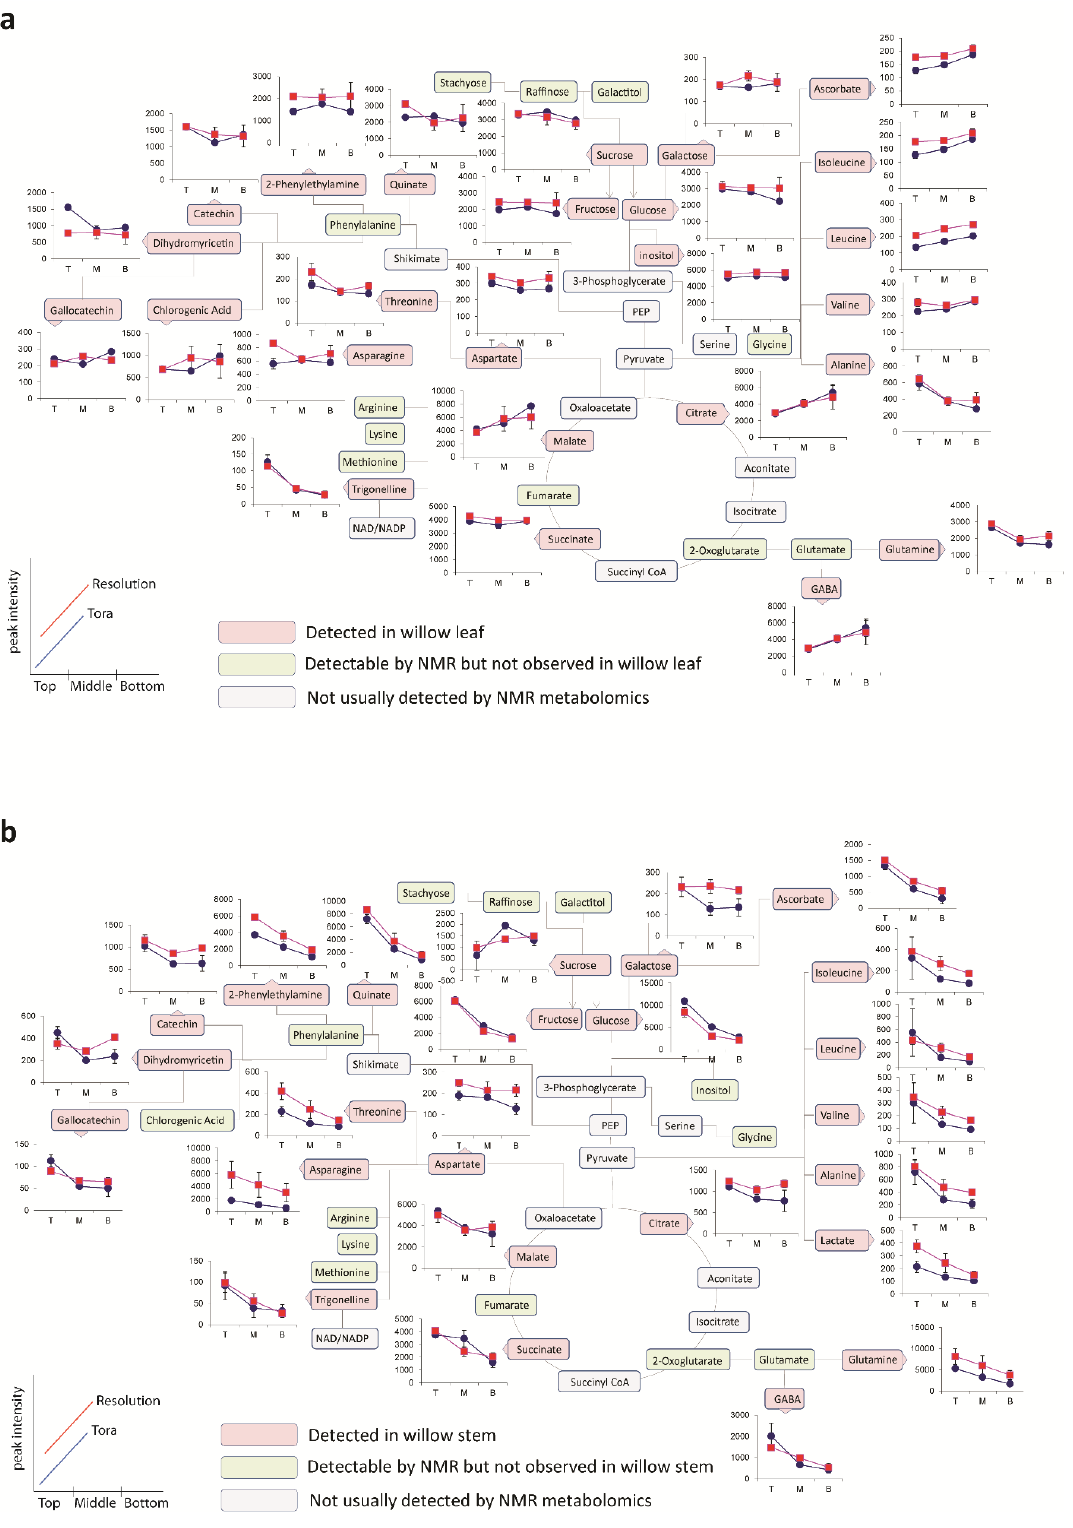
Figure 6. Metabolite trajectories for ( a ) leaf and ( b ) stem samples. Data generated from 1D 1 H-NMR data using binned regions for characteristic peaks for each metabolite. Plot intensities represent the intensity value of the binned